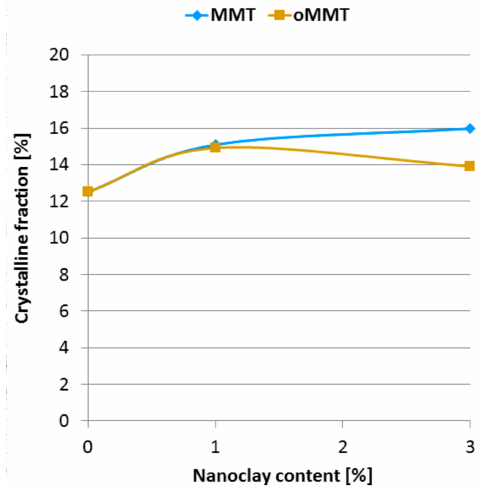
Figure 6. Crystalline fraction of the nanocomposites as a function of nanoclay